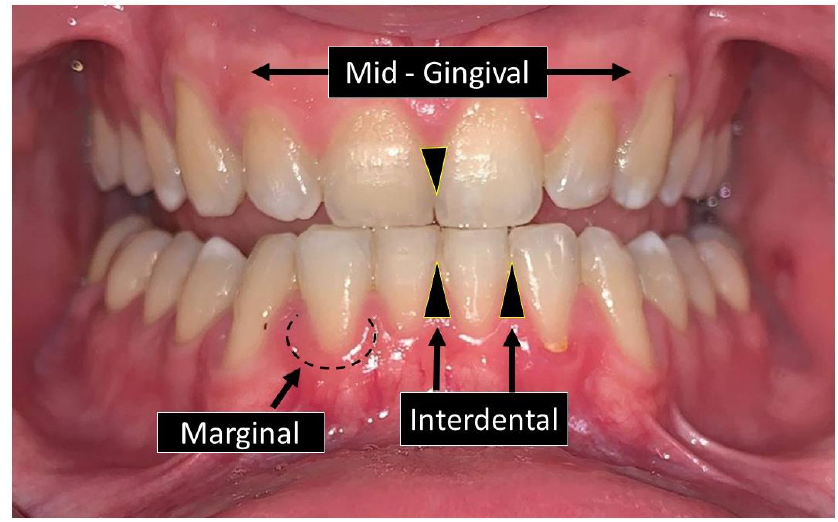
Figure 4. This figure schematizes the areas used for evaluating gingival abrasions: mid-gingival, interdental and marginal. Data collected for the test group (a total of 20 subjects) showed that 75% of subjects maintained a stable gingival health (H-H) after using a revealing solution that highlighted the abrasive surfaces of the oral epithelium. Table 2. Gingival Abrasion Assessment ( 1 : end of study; 2 : 48 h after finishing the study and without brushing teeth; 3 : interdental; 4 : mid-gingival; 5 : marginal; 6 : healthy (from ≤2 mm to ≤4 mm); 7 : not healthy (from >4 mm to >5 mm).